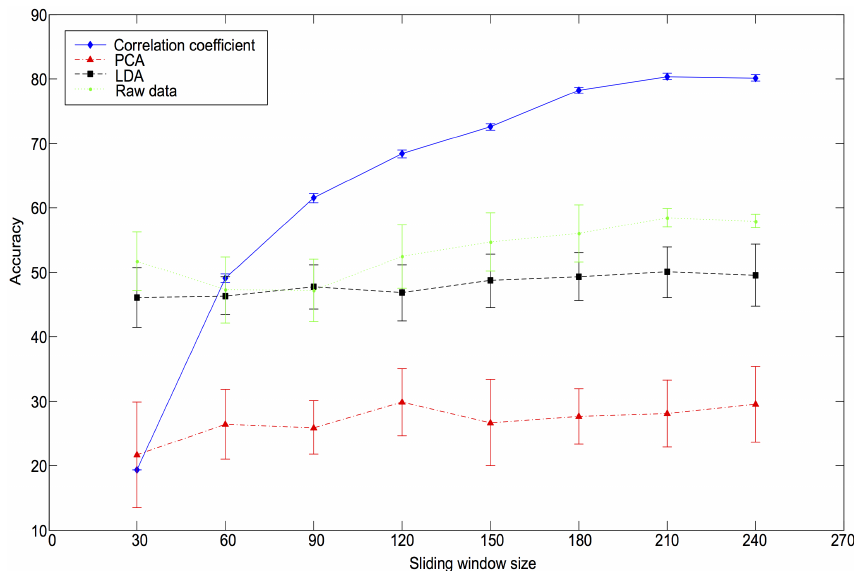
Figure 4. The performance variation of target-feature-extraction methods under the condition of different sliding window sizes. Table 4. Comparison of four feature extractions under the condition of different sliding window